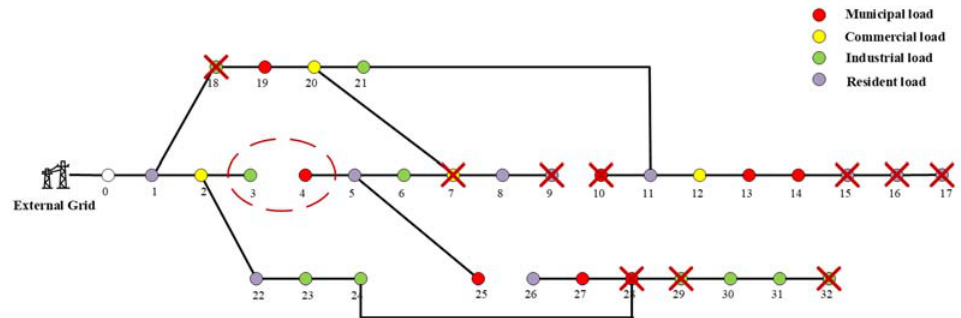
Figure 12. Removed loads distribution in Scenario 2.